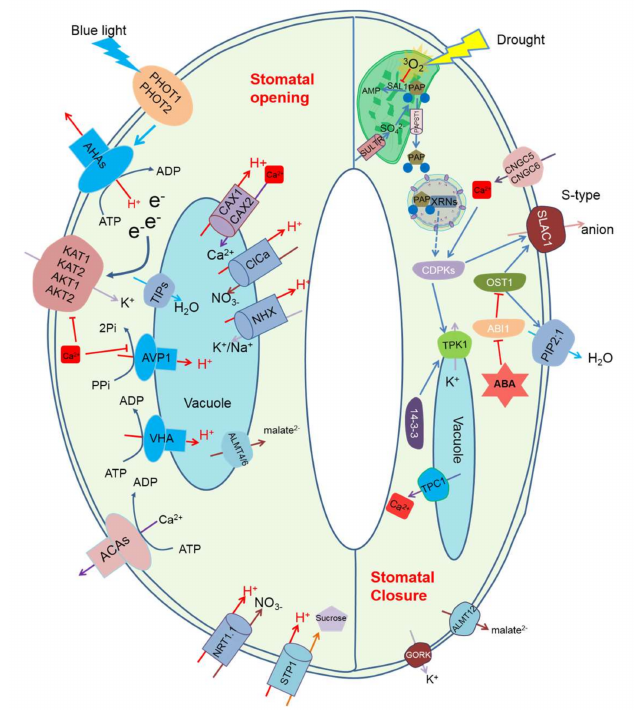
Figure 2. A schematic diagram of chloroplast-located ion transporters and retrograde signal molecule 3 (cid:48) -phosphoadnenosine 5 (cid:48) -phosphate (PAP), and their roles in stomatal regulation. PHOT1 and PHOT2 sense blue light, which activates plasma membrane proton pump AHAs, and this leads to the efflux